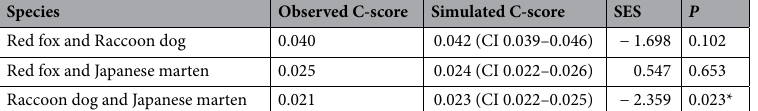
Table 2. Results of the checkerboard score. Simulated C-score represents the mean and confidence interval of a null model distribution generated using a randomization algorithm. The positive SES (standardized effect size) indicates an observed co-occurrence at a rate smaller than that expected by chance (partitioning); a negative effect size indicates an observed co-occurrence at a rate greater than that expected by chance (co-occurrence). The number of presence of data was 479 for red foxes, 460 for raccoon dogs, and 239 for Japanese martens. Asterisk represents P < 0.05.